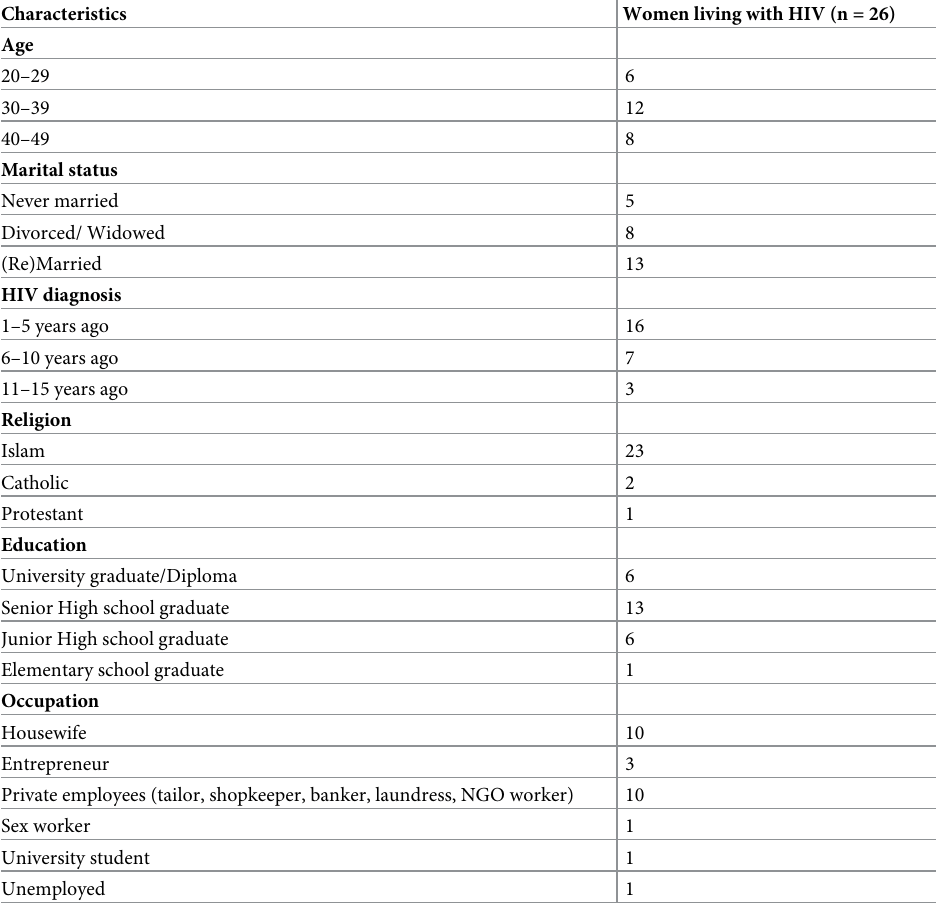
Table 1. Characteristics of the